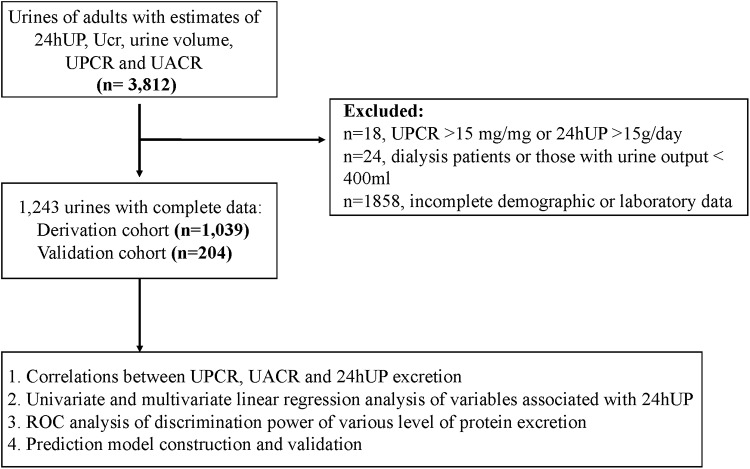
Study flow chart.Abbreviation: 24hUP, 24h urine protein; Ucr, urine creatinine; UPCR, urine protein-creatinine ratio; UACR, urine albumin-creatinine ratio; ROC, operating characteristic curve.